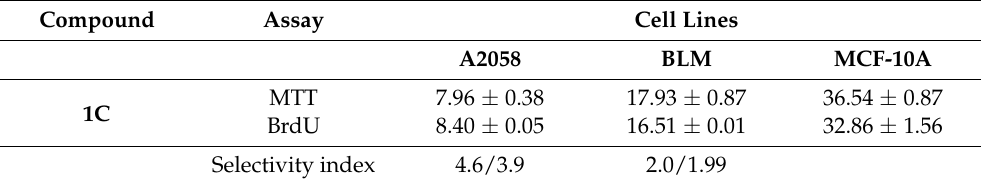
Figure 1. Effect of 1C on BrdU incorporation in A2058 ( A ) and BLM ( B ) cells. Melanoma cells were exposed to chalcone 1C at concentrations ranging from 5 to 20 μ mol/L for 72 h. The data show the mean ± SD values of three independent experiments. Statistical significance: * p < 0.05, ** p < 0.01, *** p < 0.001 vs. DMSO. Table 2. Comparison of MTT and BrdU IC50 ( μ mol/L) of 1C on melanoma cell lines and noncancer cell line MCF-10A.